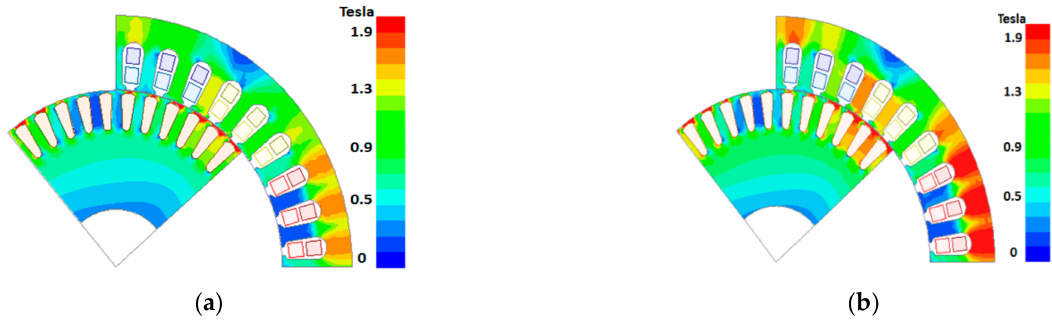
Figure 6. Flux density distribution for g = 0.488 mm, ( a ) auxiliary winding with 0 µ F, ( b ) auxiliary winding with 86 µ